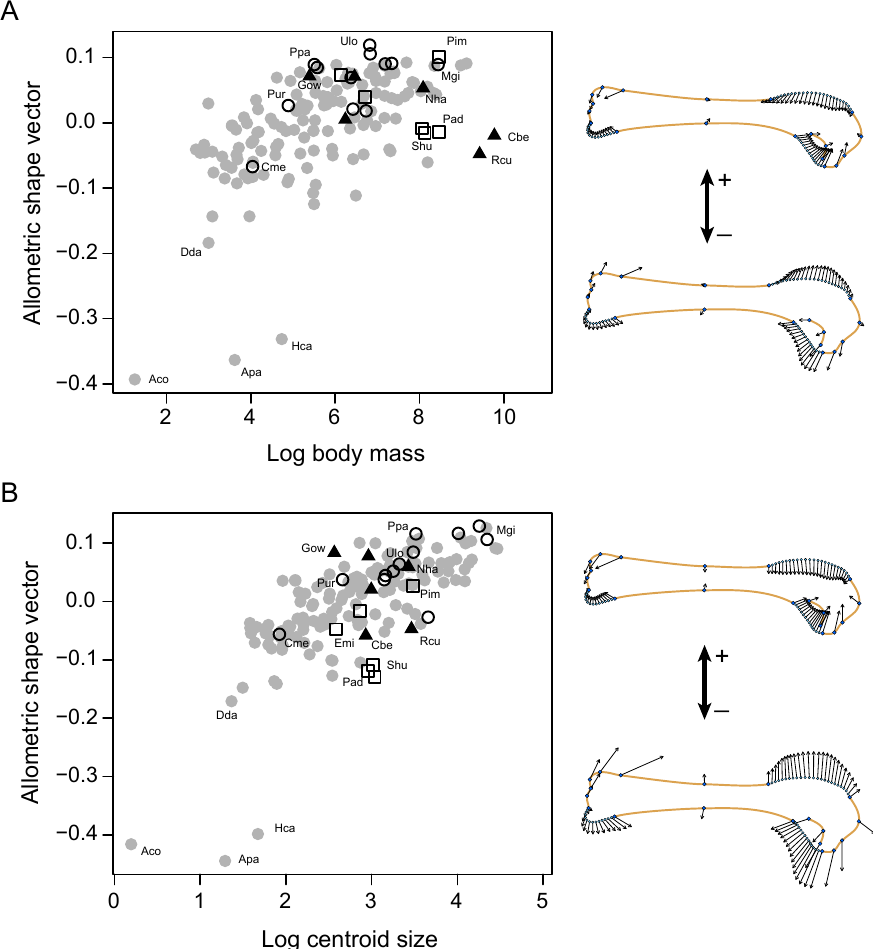
Figure 5. Allometric scaling of the humeral shape (Procrustes coordinates) on both, body mass ( A ) and centroid size ( B ). Shape changes associated with each allometric vector are shown by vector graphs. Symbols’ shape corresponds with the wing function provided in Figure 2. Abbreviations: Aco, Archilochus colubris ; Apa, Apus pacificus ; Cbe, Casuarius bennetti ; Cme, Cinclus mexicanus ; Dda,